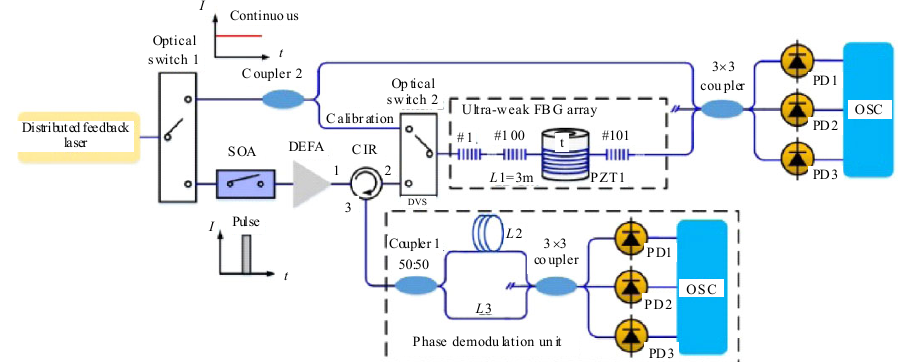
Fig. 5 Structure for experiment, all UWFBGs have same reflectivity and central wavelength. When optical switch 2 connects UWFBG array to coupler 2, a standard Mach-Zehnder interferometer is to calibrate the